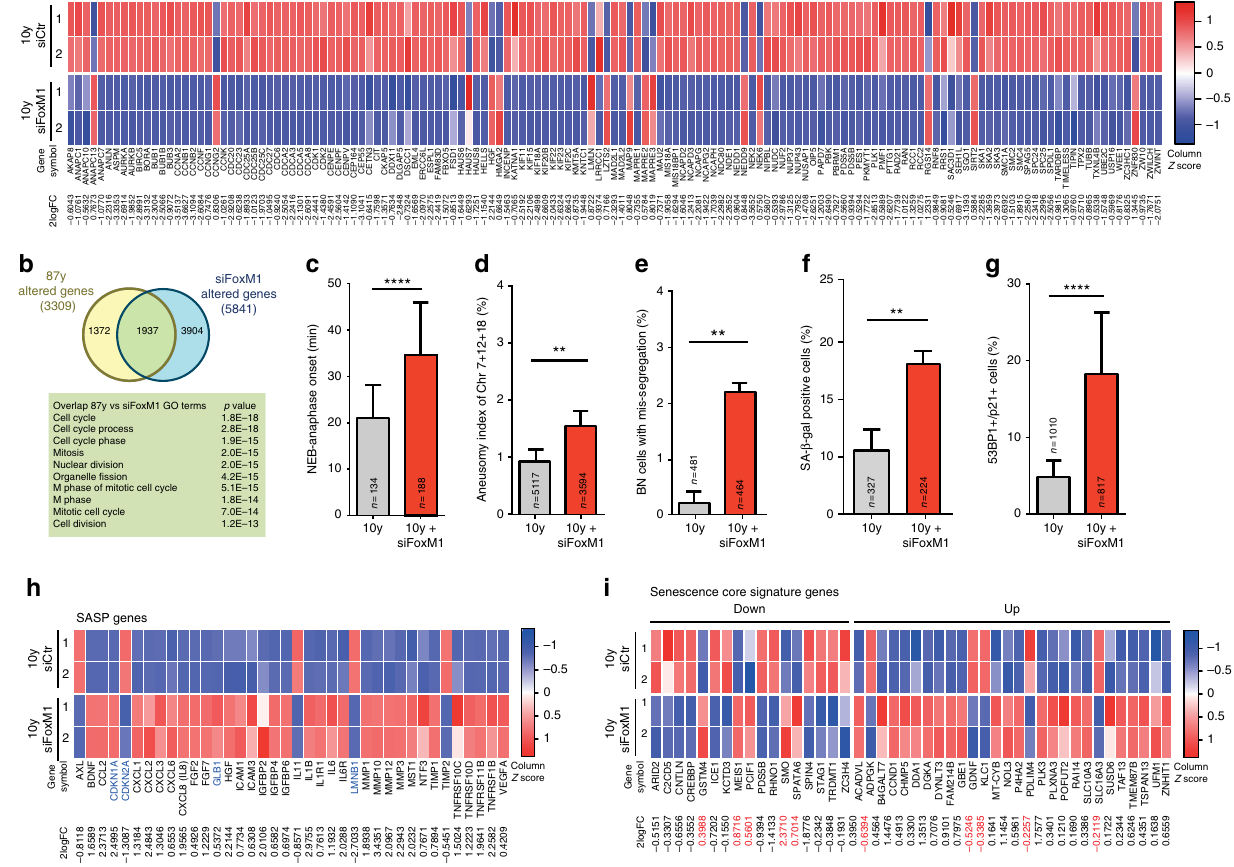
Fig. 5 FoxM1 repression dictates cellular phenotypes associated with aging. a Heatmap of genes within the “ mitotis ” GO term differentially expressed between control and FoxM1 siRNA-depleted 10-year-old fi broblasts (2logFC cutoff value < − 0.5 and > 0.5, p -value < 0.05, FDR < 5%, Supplementary Data 8). b Venn diagram illustrating the overlap between genes altered in 87 y and FoxM1 siRNA-depleted fi broblasts and the top ten altered GO terms (Supplementary Data 9). c Mitotic duration (NEB-anaphase onset) of control and FoxM1 siRNA-depleted fi broblasts. d Aneusomy index in interphase FISH. e Chromosome mis-segregation rate in CytoD-FISH. f , g Percentage of cells staining positive for the senescence markers β -galactosidase ( f ) and 53BP1/ p21 ( g ). h Heatmap of SASP and senescence ( CDKN1A , CDKN2A , GLB1 , LMNB1 ) genes differentially expressed in HDF 10 y and 10 y siFoxM1 (Supplementary Data 10) 36, 37 . i Heatmap of senescence core signature genes differentially expressed in HDF 10 y and 10 y siFoxM1 (Supplementary Data 11); 2logFCs in red indicate genes behaving differently from expected 37 . In all heatmaps: p- value < 0.05; genes represented in columns and technical replicates represented in rows; Z -score column color intensities representing higher (red) to lower (blue) expression. Values are mean ± SD of three independent experiments. Sample size ( n ) is indicated in each graph. * p ≤ 0.05, ** p ≤ 0.01, *** p ≤ 0.001, and **** p ≤ 0.0001 by two-tailed Mann – Whitney ( c ) and χ